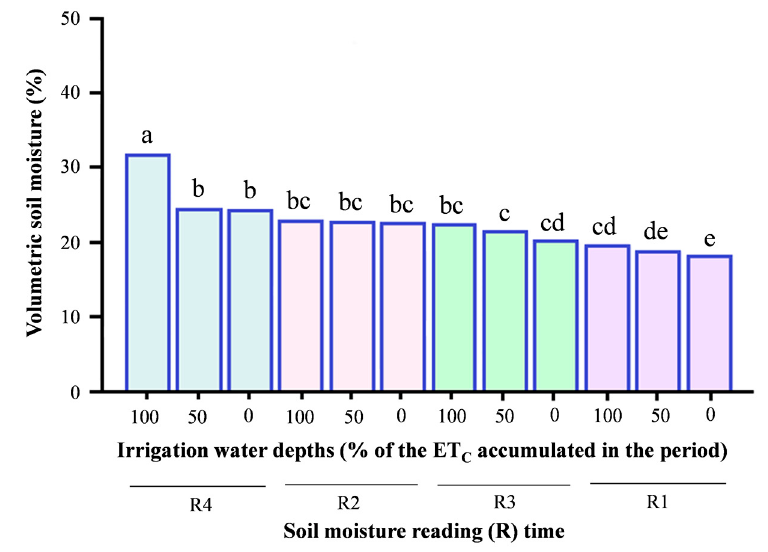
Figure 5. The soil moisture content was measured during the developmental stages of soybean grown under different irrigation conditions. R 1 , R 2 , R 3 , and R 4 represent the soil moisture readings performed on 29 September, 31 October, 5 December, and 12 December 2018, respectively. Bars followed by distinct letters show significant differences by Tukey’s test ( p < 0.05).